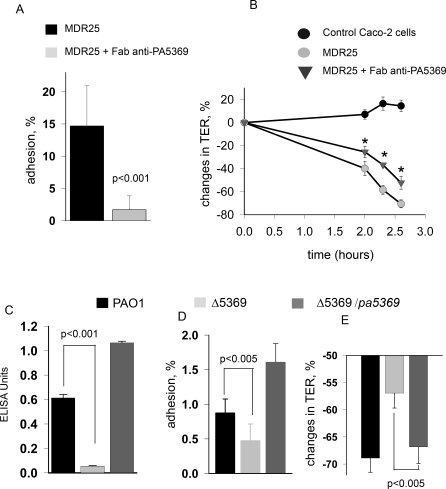
PA5369 Is Involved in Adhesiveness and Ability of MDR25 and MPAO1 to Disrupt Epithelial Integrity(A) Anti-PA5369 antibodies decrease the adhesiveness of strain MDR25 to Caco-2 monolayers. Strain MDR25 was grown on PIA plates for 2 days, bacteria were harvested, resuspended in PBS to a cell density of 5.0, and 2 μl was added to the apical surface of confluent Caco-2 cells. The Fab fragments of anti-PA5369 antibody at dilution 1:100 were included in the DMEM media (when needed) at the point of inoculation. Following 1 hour of incubation at 37°C, 5% CO2, the percentage of adherent cell was calculated. Data are mean ± SD (n = 3), p < 0.001 (Student t-test).(B) Anti-PA5369 antibodies attenuate the ability of strain MDR25 to disrupt Caco-2 monolayer integrity. Strain MDR25 was grown on PIA plates for 2 days, bacteria were harvested, resuspended in PBS to a cell density of 5.0, and 2 μl was added to the apical surface of confluent Caco-2 cells grown in transwells. The Fab fragments of anti-PA5369 antibody at dilution 1:100 were included in the DMEM media at the point of inoculation. Transepithelial resistance (TER) was measured dynamically as previously described [2]. The control group reflects the TER of Caco-2 cells in the absence of MDR25. Data are mean ± SD (n = 3), p < 0.005 (Student t-test).(C) Detection of surface associated PstS by ELISA in strain MPAO1 and derivative strains. Data are mean ± SD (n = 3), p < 0.001 (Student t-test).(D) PA5369 is involved in the adhesiveness of MPAO1 to Caco-2 cell monolayers. MPAO1 and its derivative strains were grown in TSB overnight, and 2 μl added to the apical surface of confluent Caco-2 cells. Following 1 hour of incubation at 37°C, 5% CO2, the percentage of adherent bacteria was calculated as previously described [2]. Data are mean ± SD (n = 3), p < 0.005 (Student t-test).(E) PA5369 is involved in the ability of MPAO1 to disrupt Caco-2 monolayer integrity. MPAO1 and its derivative strains were grown in TSB overnight, and 2 μl added to the apical surface of confluent Caco-2 cells grown in transwells. Transepithelial resistance (TER) of Caco-2 cells was measured after 7 hours of co-incubation with P. aeruginosa strains. Data are mean ± SD (n = 3), p < 0.005 (Student t-test)